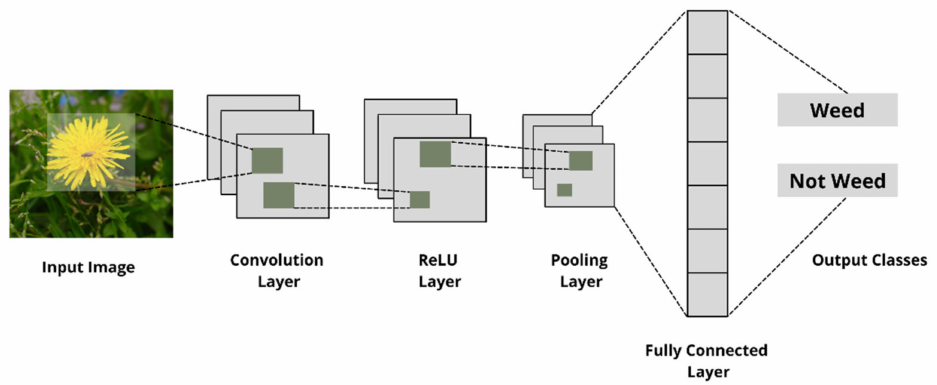
Figure 4. An illustration of the CNN framework for image classification. A CNN model’s input image is structured in three dimensions: height (m), width (m), and depth (r), where height (m) equals the width (m), and the depth (r) is referred to as channel number. For example, the depth (r) of the RGB image in Figure 4 equals three (three bands). The available kernel filters for the convolution layer will be designated by the letter k (n × n × q). However, n must be less than m, and q must be equal to or less than r. The dot product between the input and the weights is calculated by the convolution layer using Equation (5)